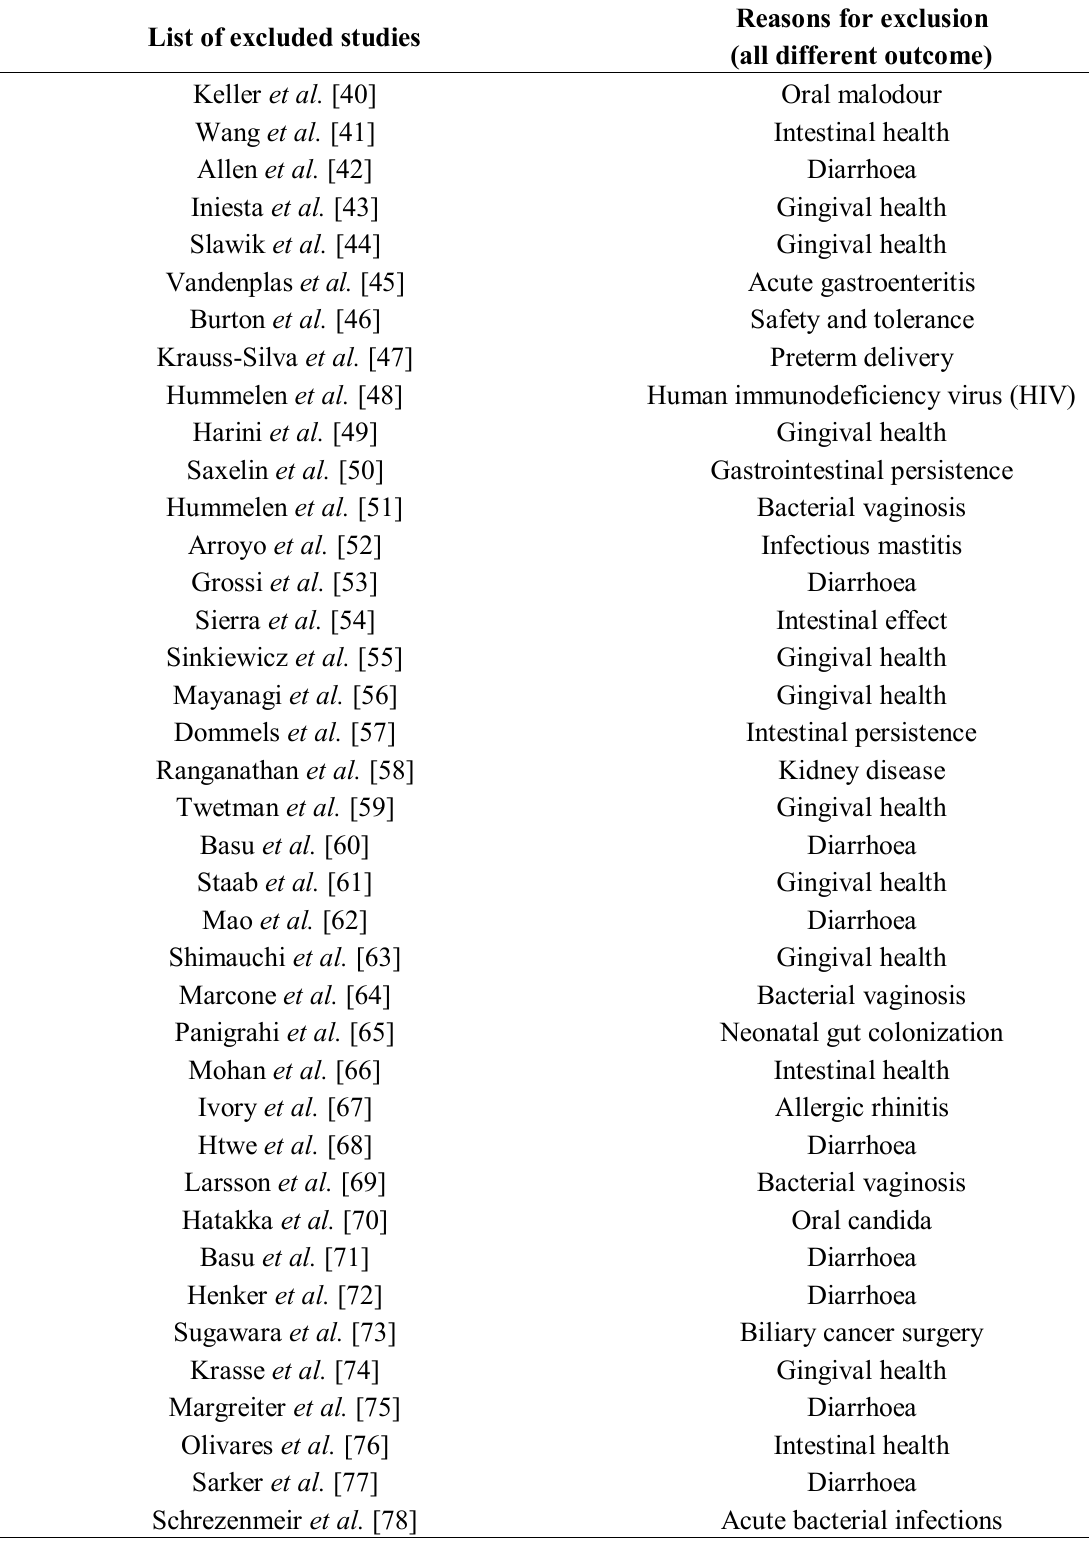
Table 1. List of papers not included in the